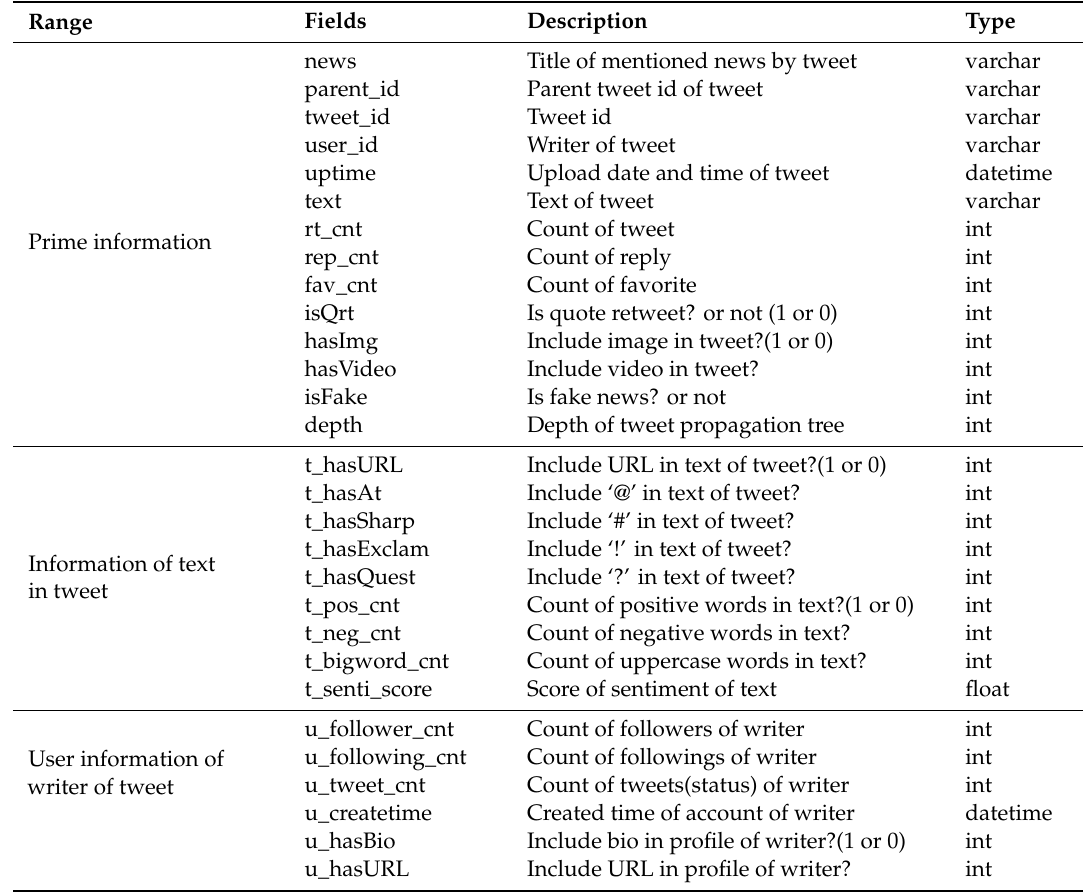
Table 1. The schema of